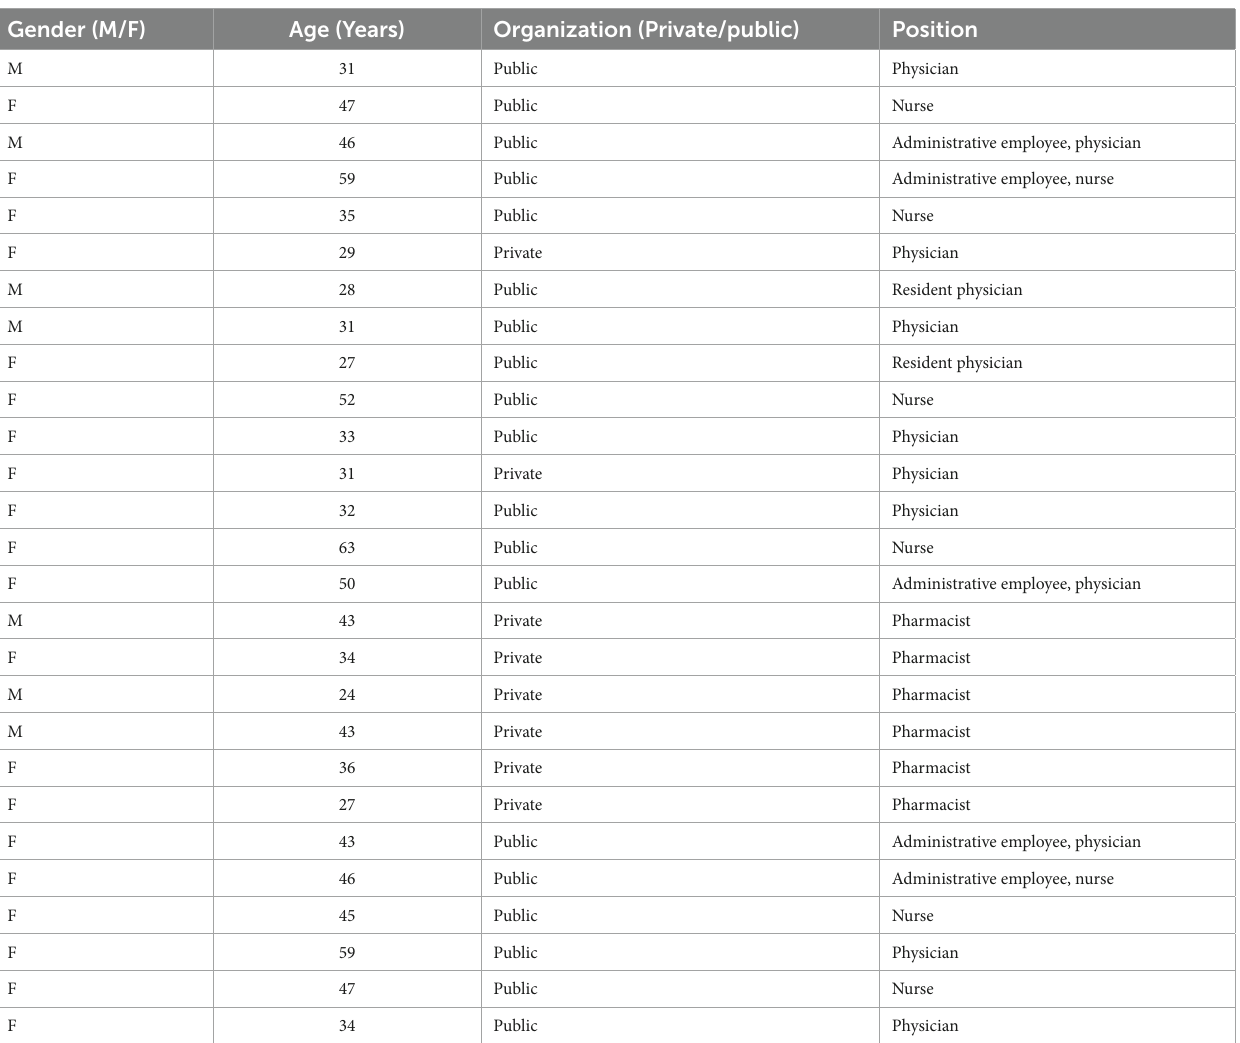
Table A1 Demographic characteristics of the study